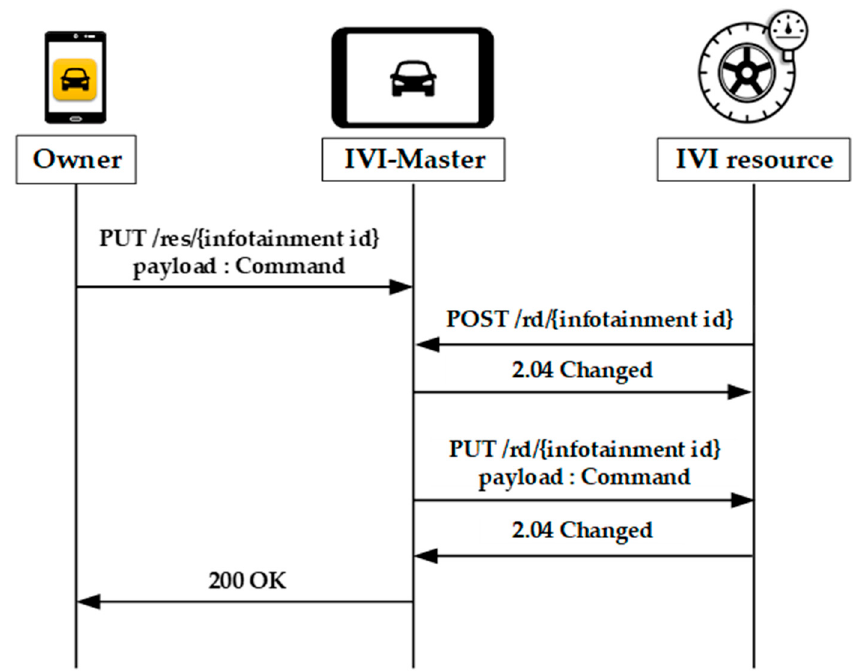
Figure 9. Resource control for owner.